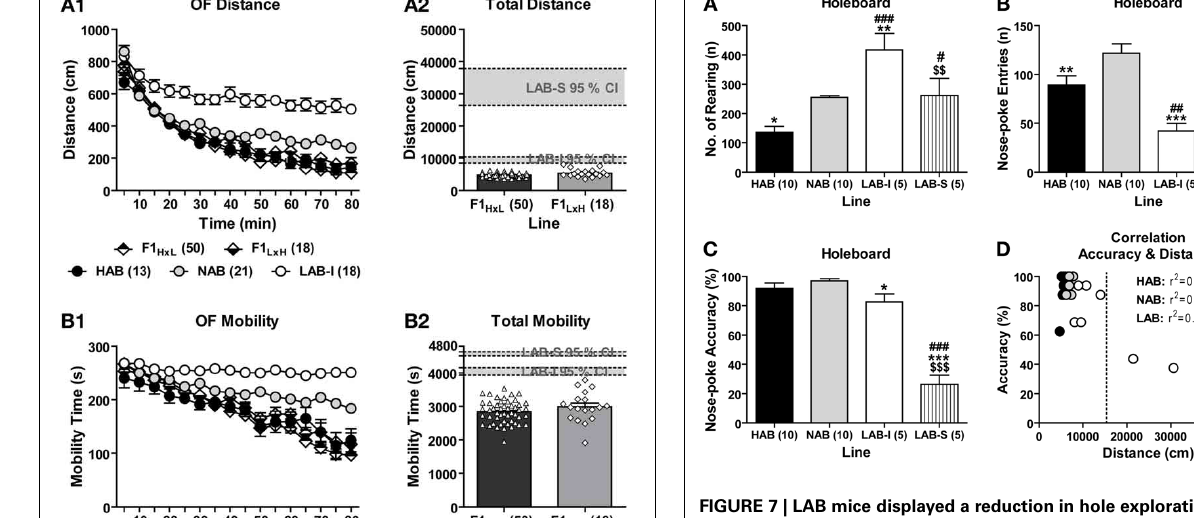
FIGURE 7 | LAB mice displayed a reduction in hole exploration. In the hole-board test (30-min exposure), (B) LAB-I and LAB-S mice showed less downward hole exploration than HAB and NAB, which was different from the (A) upward vertical exploration (i.e., number of rearing). (C) Compared to HAB, NAB, and LAB-I mice, LAB-S mice showed the poorest performance in nose-poke accuracy, which describes how many of the 16 holes had been visited at least once over the course of the exposure. (D) Intriguingly, there was an inverse relationship between locomotor activity and accuracy of hole exploration in LAB mice, but not in HAB and NAB mice. Note that LAB-I and LAB-S could also be distinguished in the hole-board by the threshold of 15,000cm (dashed line). Mean ± SEM. ∗∗∗ p < 0 . 001; ∗∗ p < 0 . 01; ∗ p < 0 . 05 vs . NAB. ### p < 0 . 001; # p < 0 . 05 vs . HAB. $$$ p < 0 . 001; $$ p < 0 . 01; $ p < 0 . 05 vs . LAB-I (ANOVA followed by post-hoc Newman–Keuls